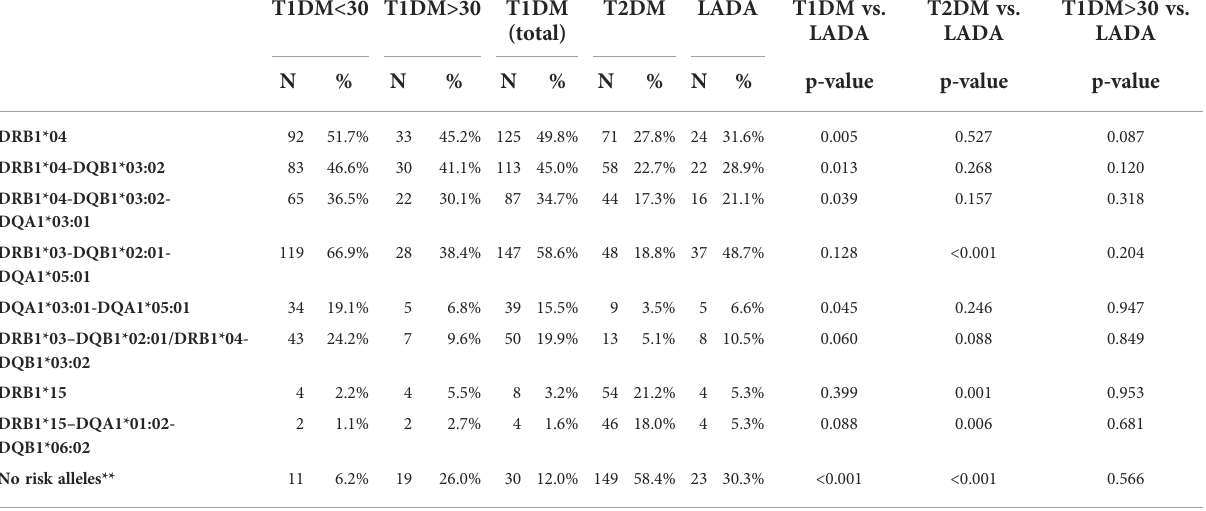
TABLE 3 HLA allele and haplotype distribution among groups.